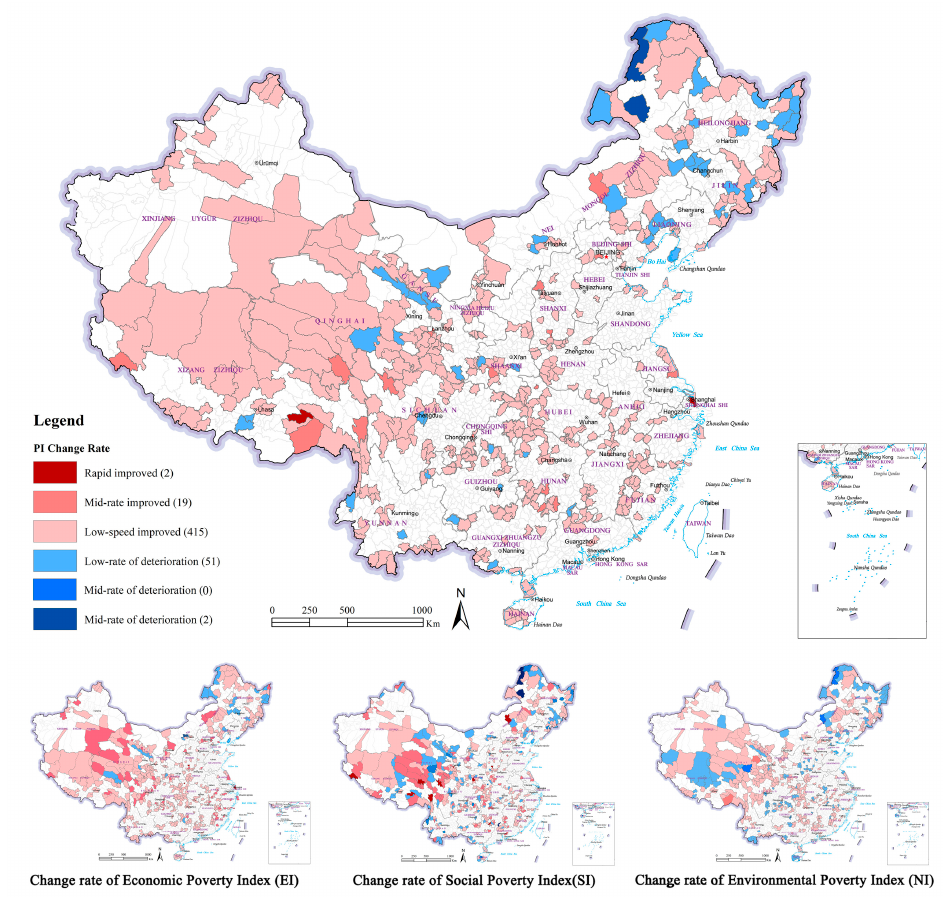
Figure 4. Spatial pattern of the PI change